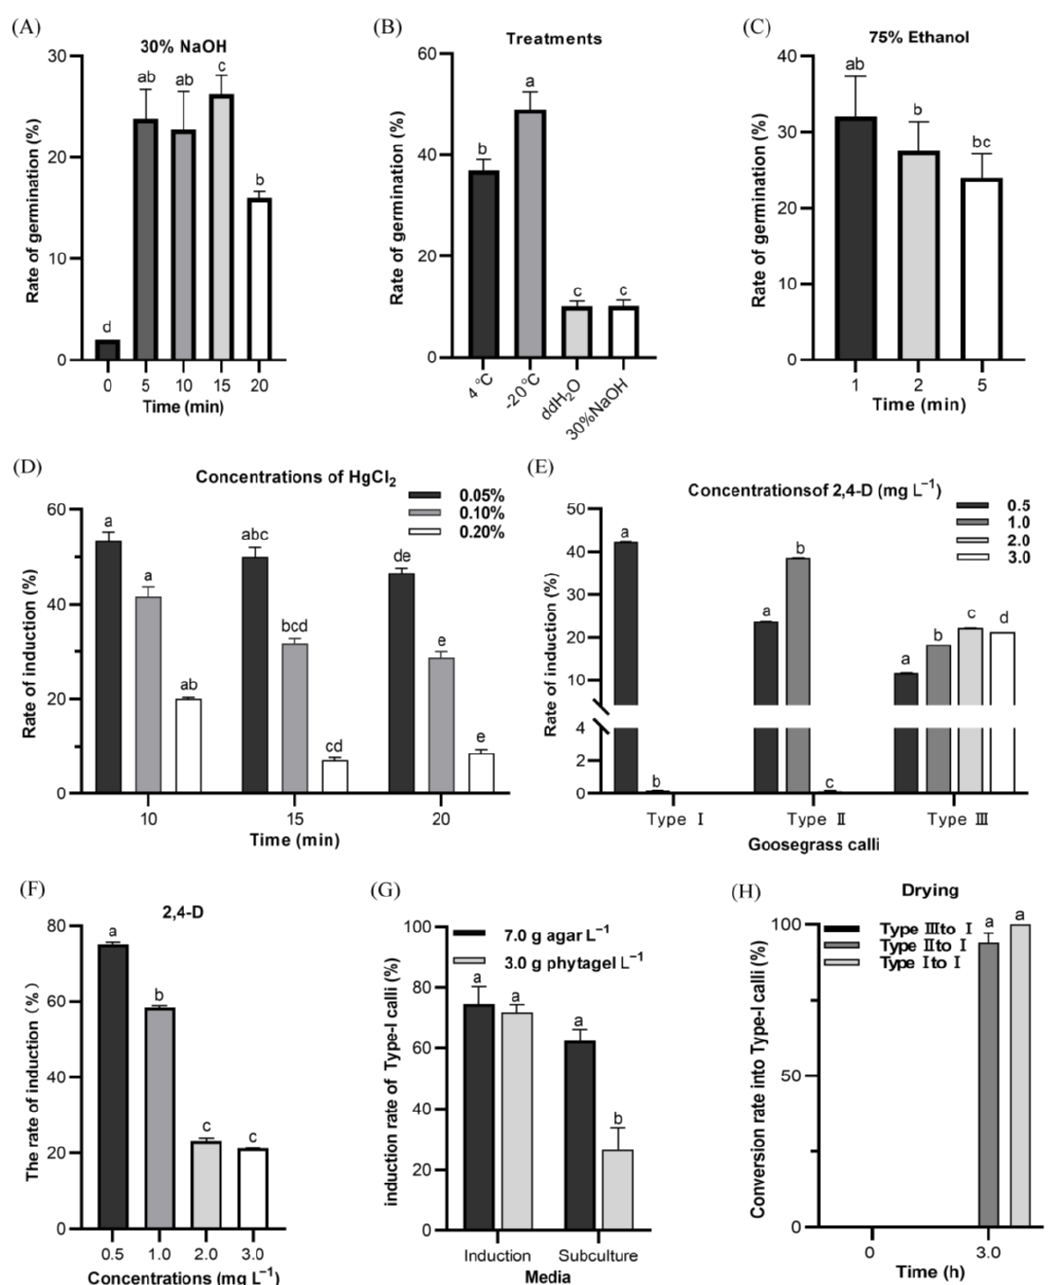
Figure 2. The optimal conditions for seed gemination and callus induction of goosegrass. ( A ) The germinating rates of seeds in different treatment time of 30% NaOH solutions. Non-treatment at 0 min as the control. ( B ) The germinating rates of seeds in various treatments of 30% NaOH for 15 min, ddH 2 O for 24 h, 4 ◦ C or − 20 ◦ C for about 30 days. ( C ) The germinating rates of seeds in different treatment time of 75% ethanol (and then with 0.10% HgCl 2 for 15 min). ( D ) The rates of seed inducing after the treatments of different concentrations of HgCl 2 in 75% ethanol solution. ( E ) The induction rates of the types-I to -III calli in induction media with different concentrations of 2,4-D solution. ( F ) The average of callus induction rates in induction media with different concentrations of 2,4-D solution. ( G ) The induction rates of the type-I calli in induction and subculture media with 7.0 g agar/L and 3.0 g phytagel/L, respectively. ( H ) The conversion rates of the type-II and type-III calli into type-I calli in subculture with an air drying of the medium surface for 0 h and 3.0 h, respectively, before the subculture. Different letters indicate significant differences at p <